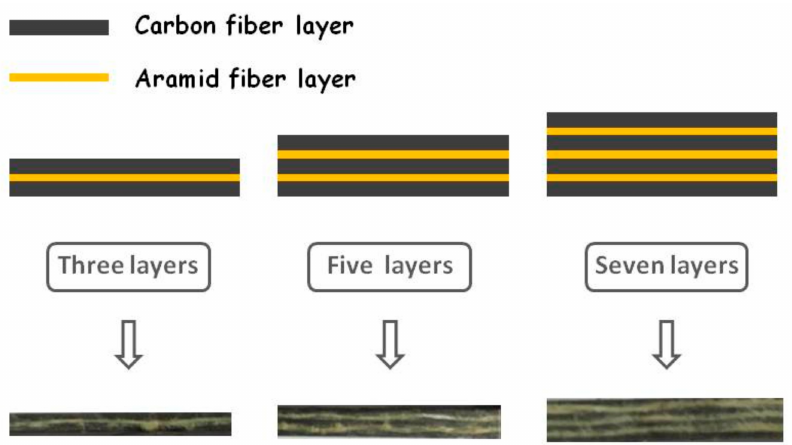
Figure 1. Schematic diagram of the carbon-aramid fiber sandwich